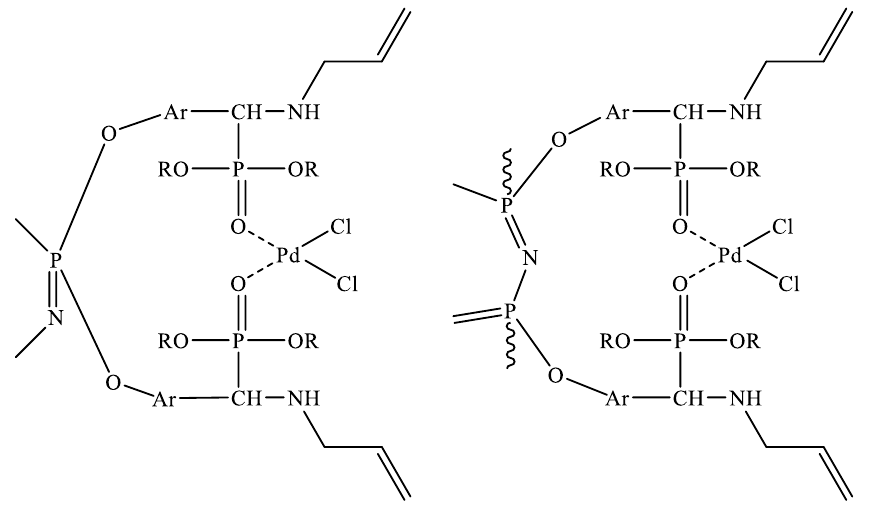
Figure 6. Palladium(II)-extractant chelate complexes with intra-sphere coordination of palladium (R = C 2 H 5 , Ar = p -C 6 H 4 ).